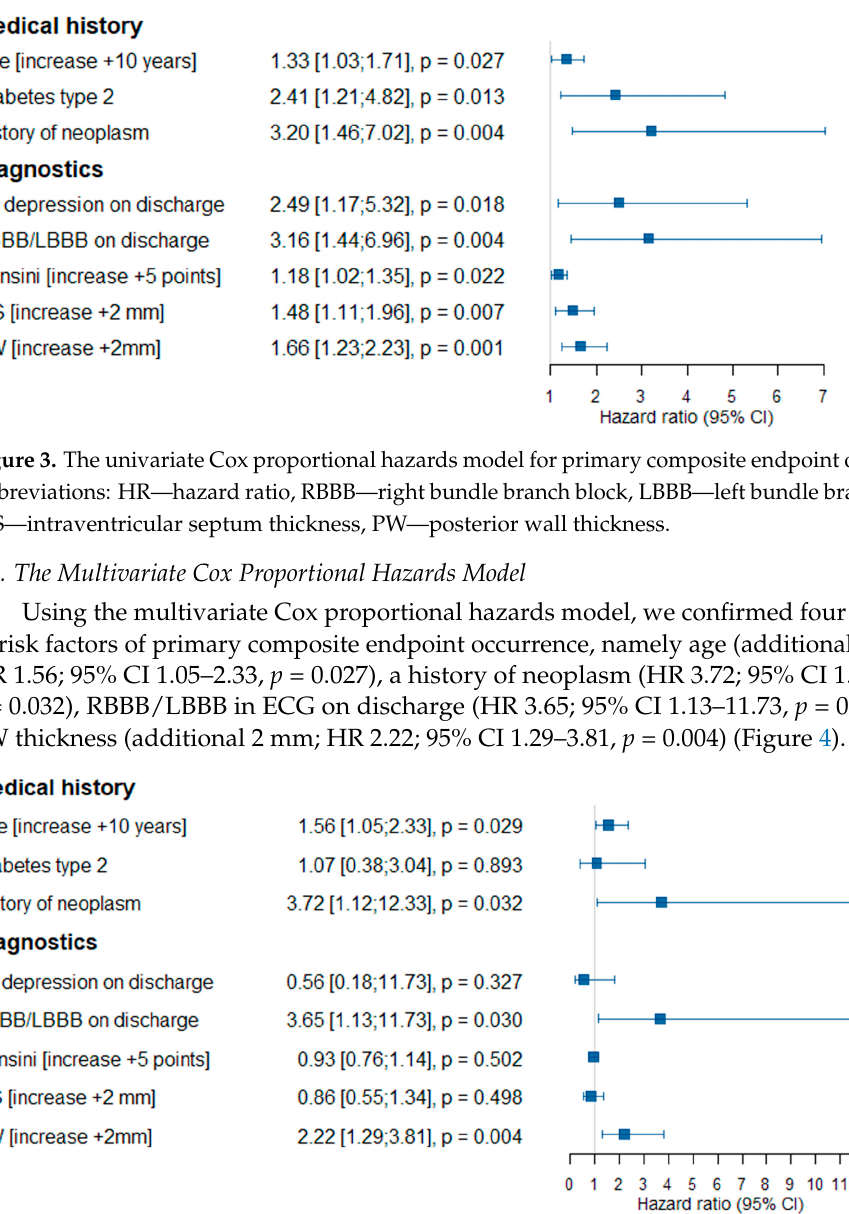
Figure 2. Primary composite endpoint free survival in patients with MINOCA and RBBB/LBBB in ECG on discharge ( A ) and history of neoplasm ( B ) (Kaplan–Meier estimator). Abbreviations: RBBB—right bundle branch block, LBBB—left bundle branch block, NPL—neoplasm.